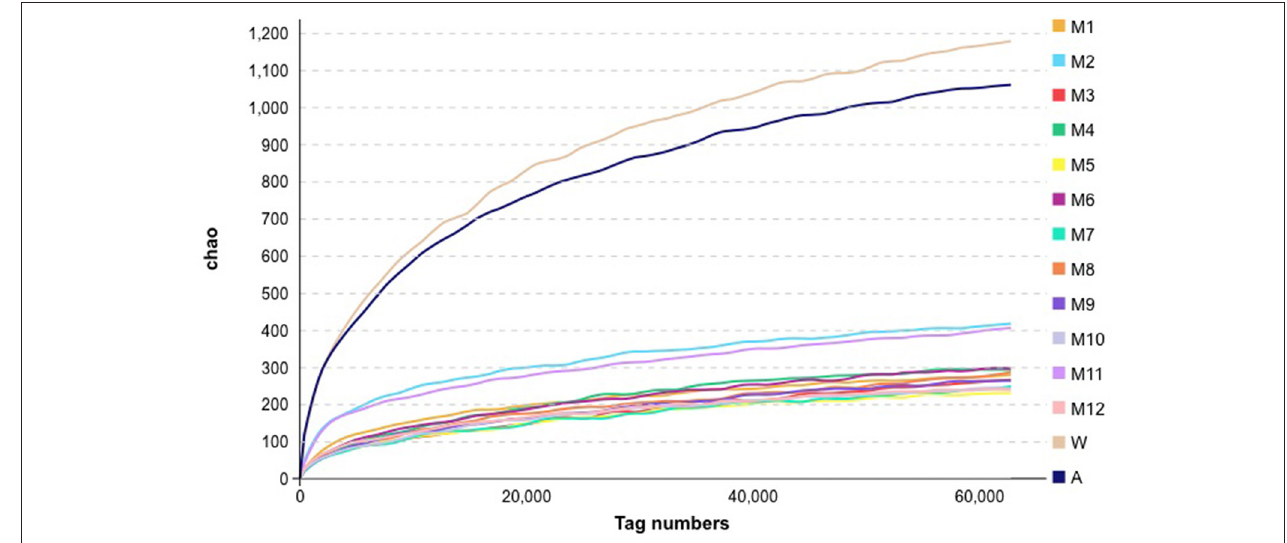
FIGURE 3 | Heatmap analysis for bacteria genera in different samples. See Figure 1 for abbreviations.